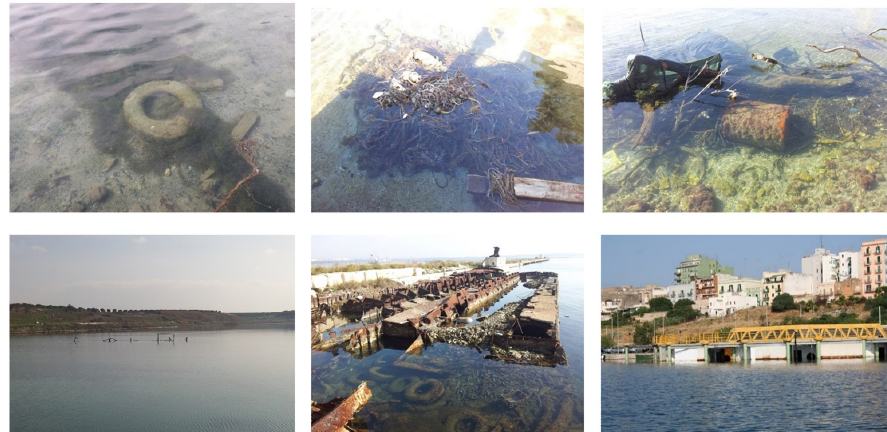
Figure 12. Some waste and wrecks identified by the mapping activities (the photos are related to post-mapping inspec- tions. First and second inlet of the Mar Piccolo (Puglia Region).